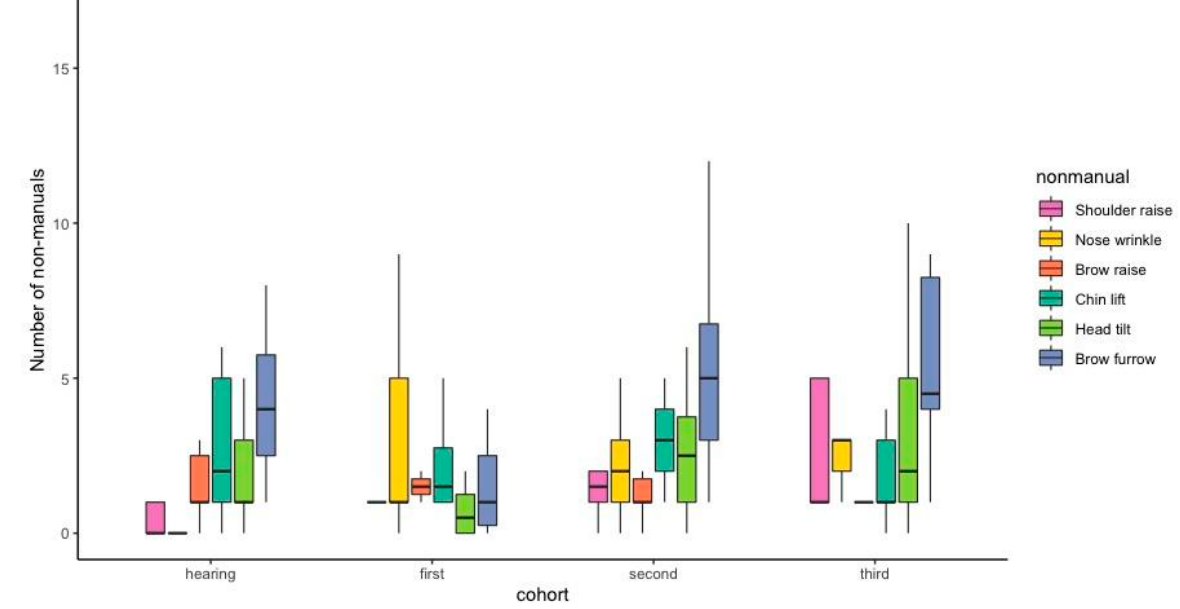
Figure 4. Number of each non-manuals type coarticulated with the wh-question word. The black line shows the median number of questions for which the non-manual was coarticulated with the wh-question word. Whiskers represent maximum and minimum scores, excluding extreme outliers. Non-manual categories are ordered according to mean frequency as represented in Figure 2, with the more frequent to the right. (The unusually skewed bar for the shoulder raise in the third cohort results from a single participant who repeated questions multiple times per item, raising the shoulders multiple times per question.) Figure created using the ggplot2 package (Wickham 2016) in the R programming environment.